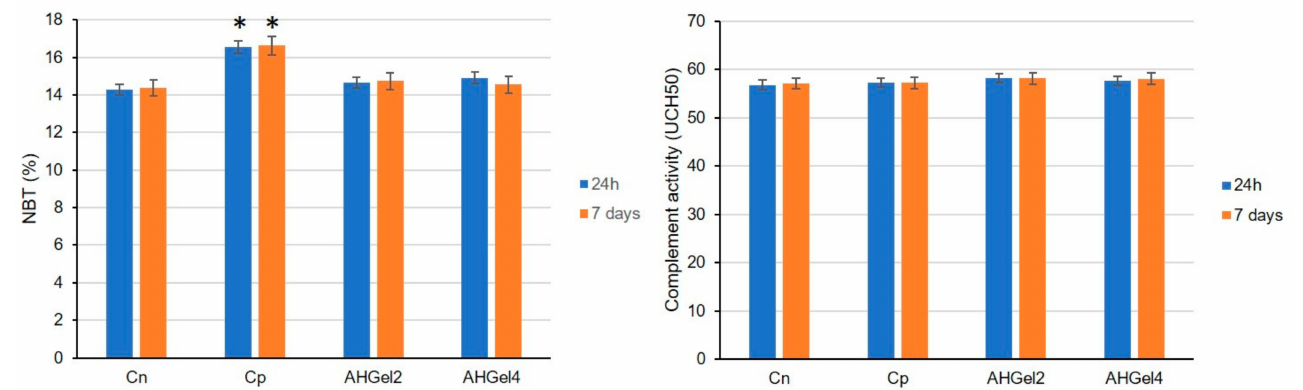
Figure 11. The effects of Amox-loaded scaffolds implantation on PMN phagocytic activity in periph- eral blood (NBT test) and on serum complement levels. For all data, the values are presented as mean ± S.D. * p < 0.05 versus